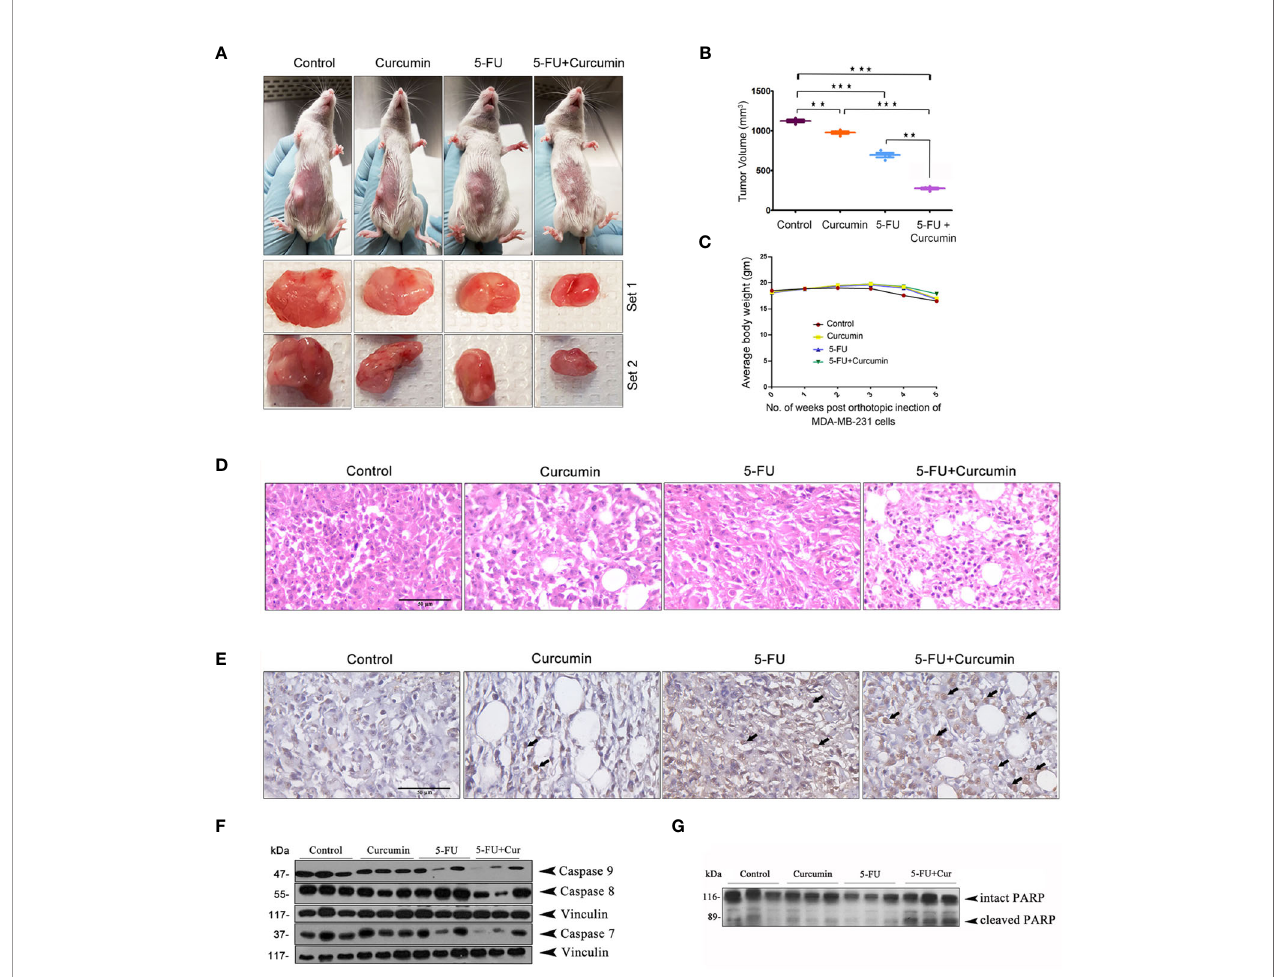
FIGURE 2 | Curcumin enhances antitumor effect of 5-FU in orthotopic xenografts of human BC in NSG mice (A) Representative images of animals from each experimental group showing differences in tumor volume upon completion of treatment. (B) The mean tumor volume (in mm3) among different experimental groups is shown. Data represent two independent sets of experiments and results are shown as the mean ± S.D. P-values were calculated with one-way ANOVA. ***P-values ≤ 0.001 and **P-values ≤ 0.01. (C) The effect of the treatment on the average body weight of animals in different groups during the study. (D) Histological changes induced by the treatments, either alone or in combination are shown. (E) Representative photomicrographs showing TUNEL staining pattern in xenograft tumor sections. Dark brown staining is indicative of nuclei with fragmented DNA. (F) Curcumin potentiates 5-FU-induced cleavage of caspases in human breast cancer xenograft treated with 5-FU + Cur. (G) Curcumin pre-treatment markedly increased 5-FU-induced PARP cleavage in the animals treated with the combination. Total proteins were extracted from tumor samples of different experimental groups as described in Methods and subjected to Western blot analysis using speci fi c antibodies against caspases 9, 8, 7 and PARP. All experiments were repeated thrice with samples from different animals of the same treatment groups. Vinculin levels are shown to monitor equal loading of